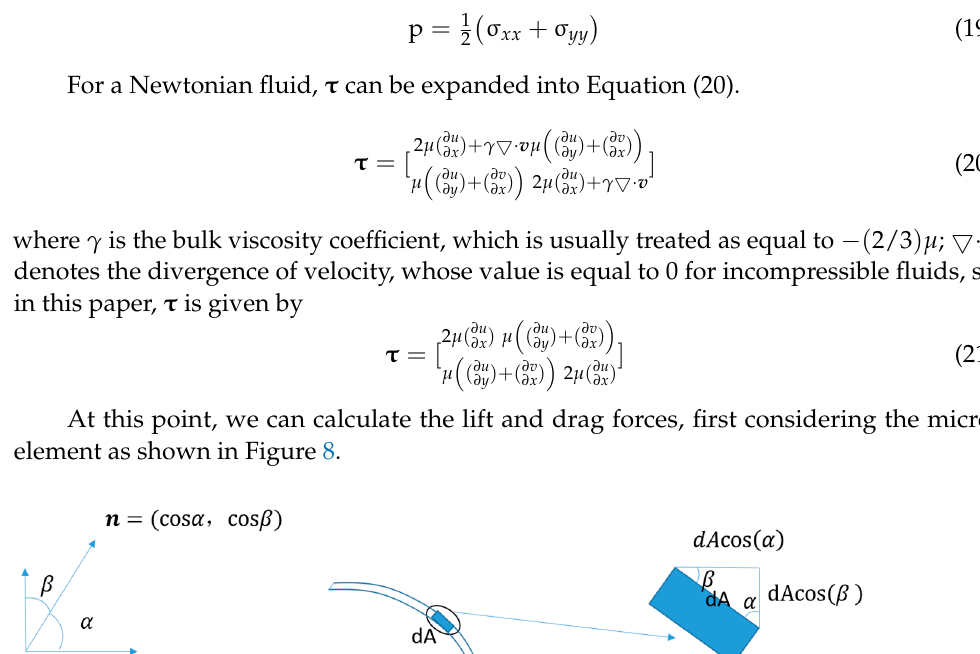
Figure 10. Lift and drag forces on micro-elements. D = (cid:3505) (cid:3428)(cid:3436)−𝑝 + 2𝜇 𝜕𝑢 𝜕𝑥(cid:3440)cos(cid:4666)α(cid:4667) + 𝜇 (cid:3436)𝜕𝑢 𝜕𝑦 + 𝜕𝑣 𝜕𝑥(cid:3440)cos(cid:4666)𝛽(cid:4667)(cid:3432) 𝑑𝐴 (cid:3002)